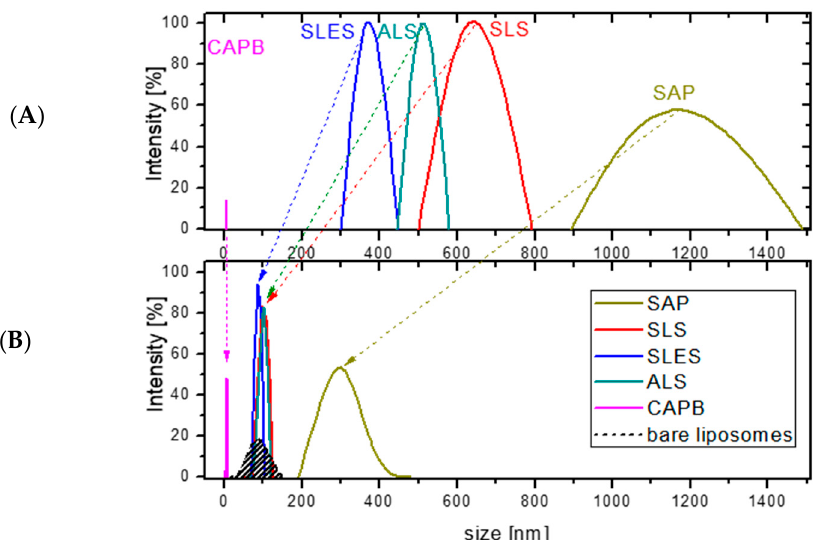
Figure 3. Particle size distribution in 5% ( w / w ) solutions of synthetic surfactants SLS, SLES, ALS, CABP and soapwort extract (SAP) in the absence ( A , top) and presence of DPPC/cholesterol (7:3, mol/mol) liposomes (total lipid concentration 1 × 10 − 2 %) ( B , bottom). The results for bare DPPC/cholesterol (7:3, mol/mol) liposomes are also shown for comparison. All measurements performed in phosphate buffer (pH 7) at room temperature, 2 h after preparation.